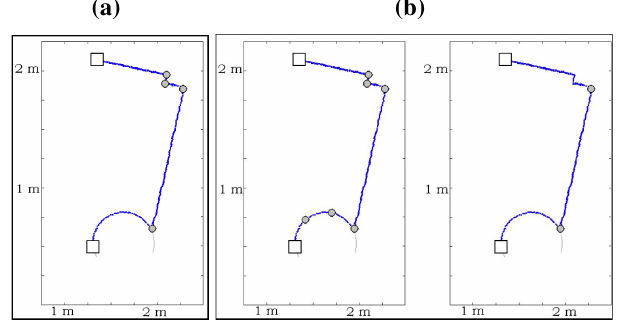
Figure 10. (a) Dominant points detected from the TAR obtained using an adaptive triangle side length; and (b) dominant points detected from the TAR obtained using a t value equal to 3 (left image) or t value equal to 15 (right